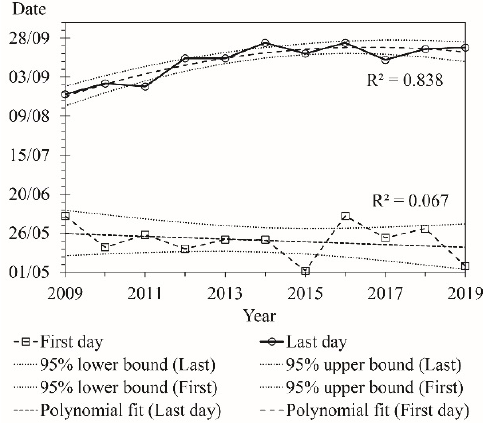
Figure 5. The dates of the seasons’ beginning and ending.